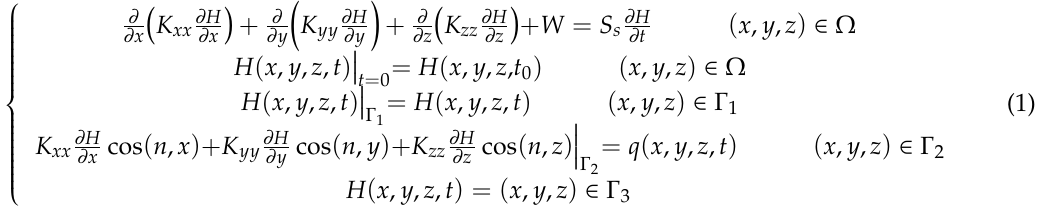
Figure 6. Dynamic variation of groundwater level in the third confined aquifer.